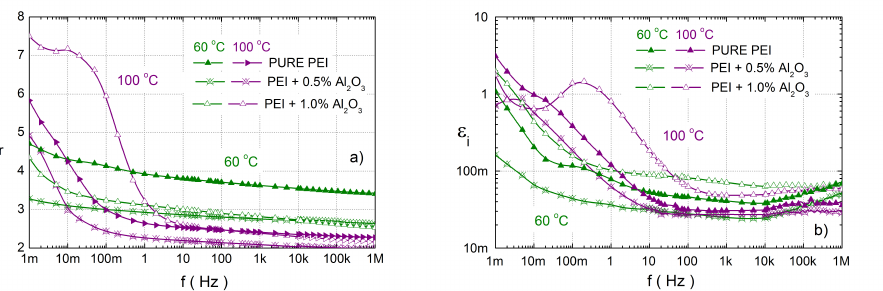
Figure 7. The frequency dependence of the real ( a ) aand imaginary ( b ) apart of the complex relative permittivity for PEI and their various nanocomposites with Al 2 O 3 at temperatures of 60 and 100 ◦